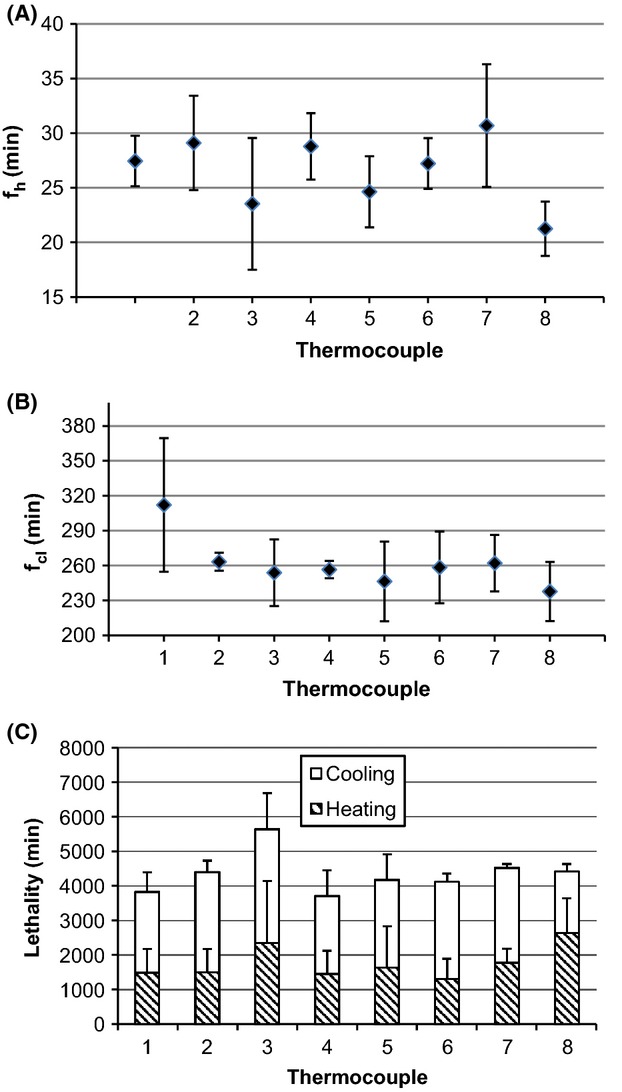
Average (95% CI) for (A) fh, (B) fcl, and (C) F82.2°C for heating and cooling of cranberries in heavy syrup, n = 3. Thermocouple location (height from bottom of container): 7.5 (geometric center), 6.5, 5.5, 5.0 (1/3 from the bottom), 4.5, 3.5, 2.5, and 1.5 cm, for thermocouple 1–8, respectively.